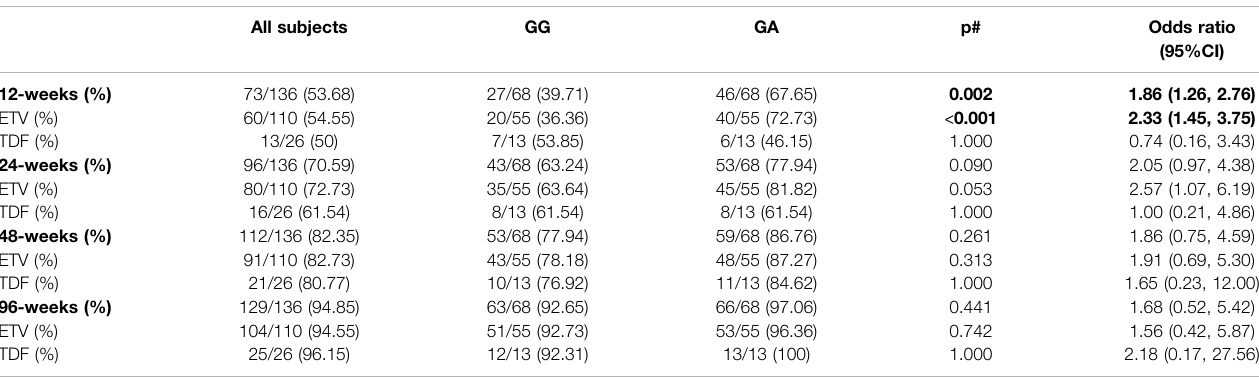
TABLE 3 | Percentage of ‡ HBV DNA Clearance at each time point.